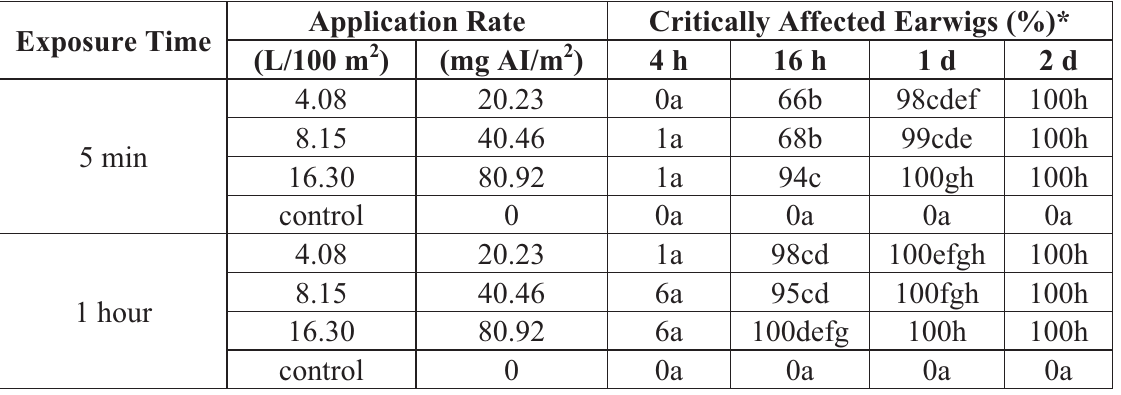
Table 1. Mean percent critically affected (ataxic, moribund, or dead) earwigs at various times after brief exposure (5 min or 1 h) to dried residues of 0.05% indoxacarb on pine wood and ceramic tile (N = 16 replicates per